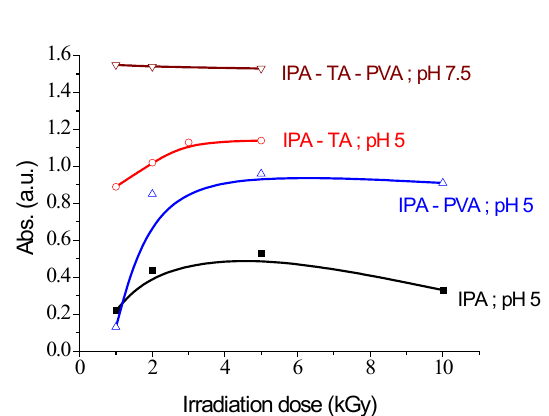
Figure 9. The absorption maximum value for AgNPs obtained at different reaction compositions and an irradiation dose of 2 kGy.